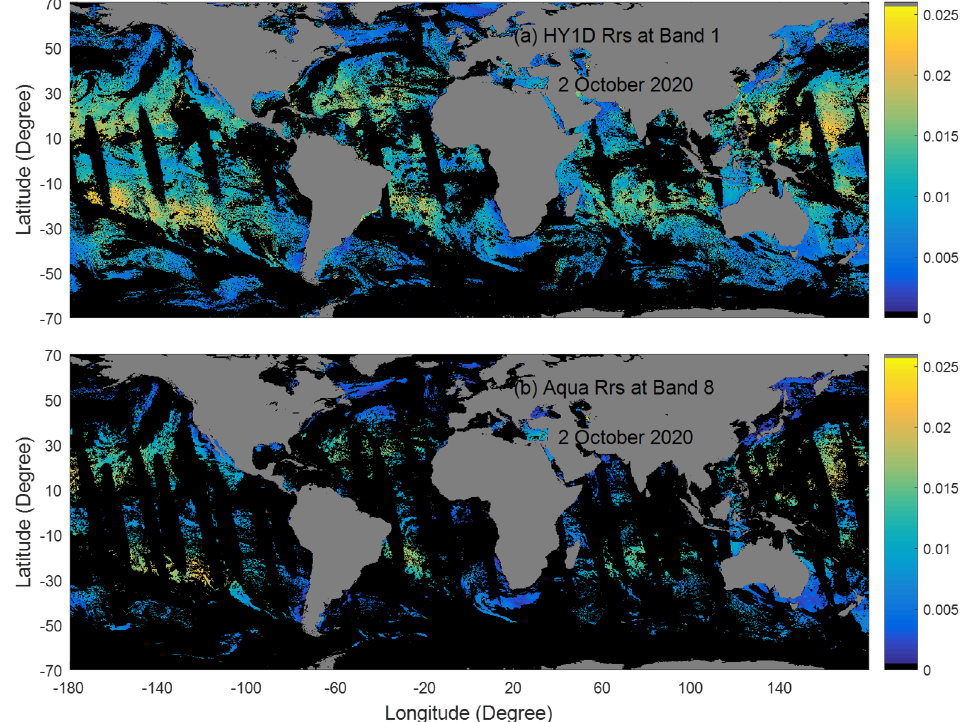
Figure 6. The comparison of the global daily R rs image on 2 October 2020 with ( a ) COCTS/HY ‐ 1D at Band 1 and ( b ) MODIS/Aqua at Band 8. The magnitudes of image pixels are indicated by the color bar with the unit of sr − 1 . Invalid pixels are masked black and land grey.